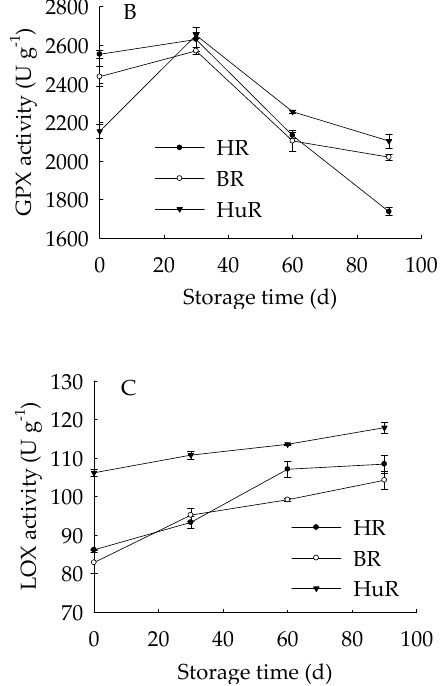
Figure 3. Changes in activities of ascorbate peroxidase (APX) ( A ), glutathione peroxidase (GPX) ( B ) and lipoxygenase (LOX) ( C ) in juice sacs of HR, BR and HuR during postharvest storage. Vertical bars represent SE of the means of three replicate assays.